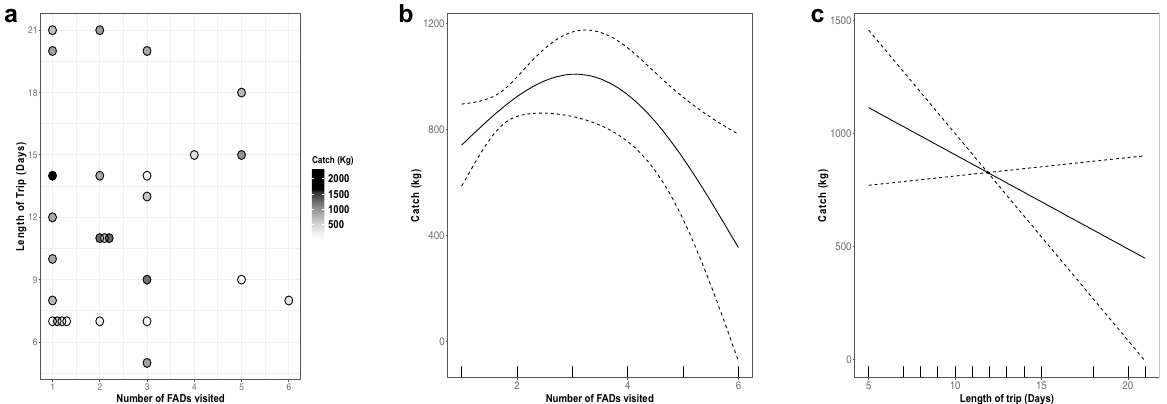
Figure 5. Patterns in catch with the number of FADs visited and the number of days in a fishing trip from the 27 vessels with port sampling data. (a) The catch data plotted against the two variables of interest (the number of AFADs visited on the x axis, and the length of the trip in days on the y axis. The points are offset to the right of a value when there are multiple observations, for ease of reading. (b) The best fitting model for the data based on AICc for the number of FADs visited and the catch in kg (with a smooth term for the number of FADs visited during a trip). (c) The length of the trip in days and the catch in kgs of the best fit model for the data based on AICc.